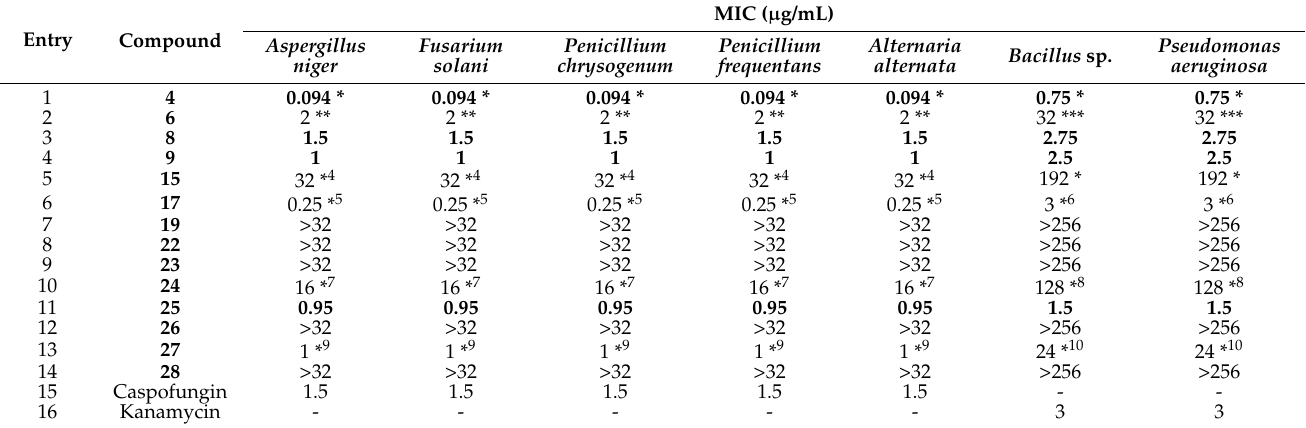
Table 1. In vitro antifungal and antibacterial activities of compounds 4 , 6 , 8 , 9 , 15 , 17 , 19 , 22–28